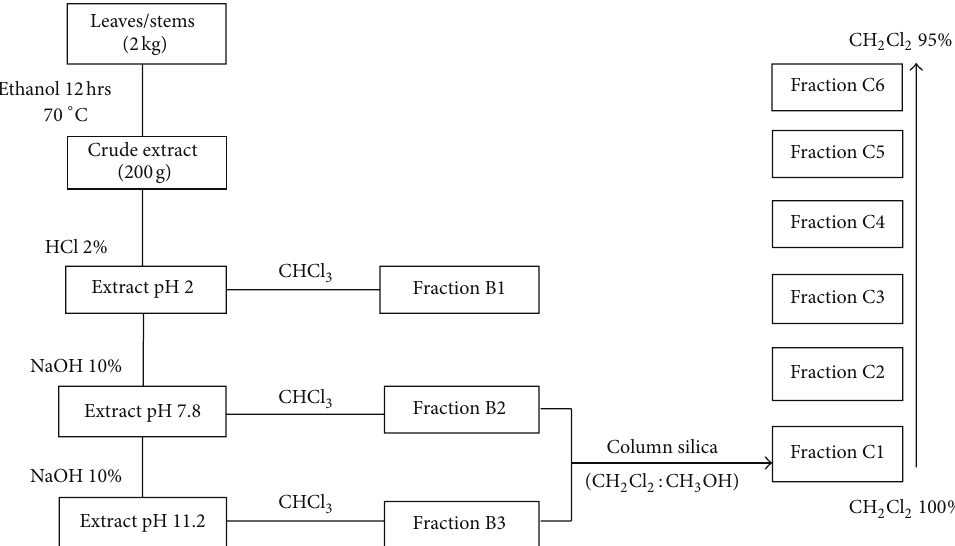
Figure 1: Diagram of fractionation of Tabernaemontana catharinensis extract.